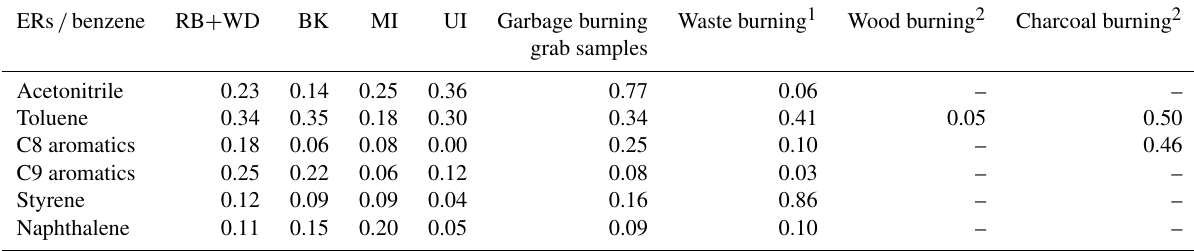
Table 6. Emission ratios of NMVOCs / benzene for acetonitrile and aromatic hydrocarbons derived from the PMF model for different sources and comparison with the ratios for different source categories reported in previous studies.